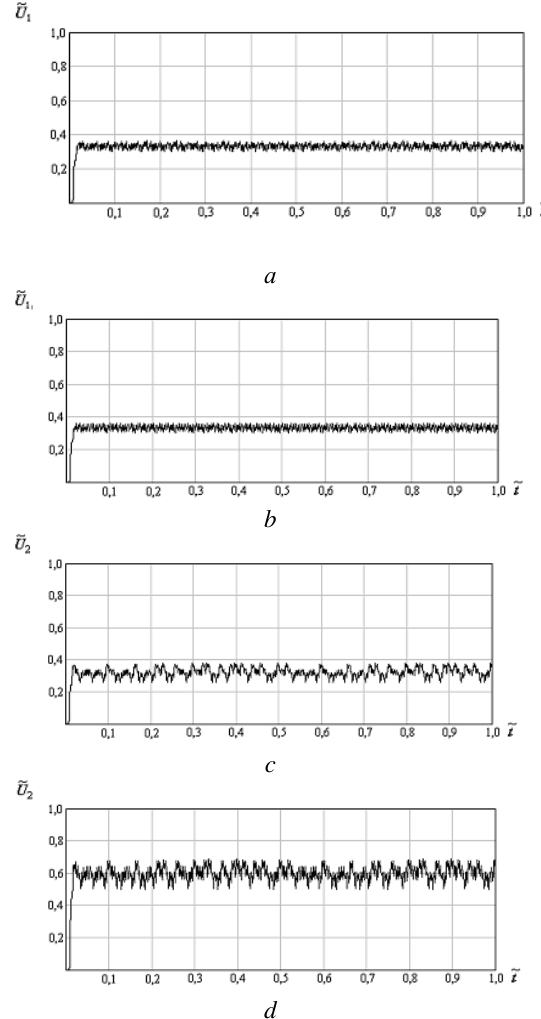
Fig 1. Resulting AE signals during the normal friction pair wear at the prevailing mechanism of wear: a – the destruction of type I structures; b, c – the destruction of type II structures. The starting time of the destruction of each subsequent structure type (I or II) is permanent and equals to 0.004, but plastic deformation unit values vary. (cid:2) U – the normal Values B and b are equal to B=10, b=10. meaning for max .